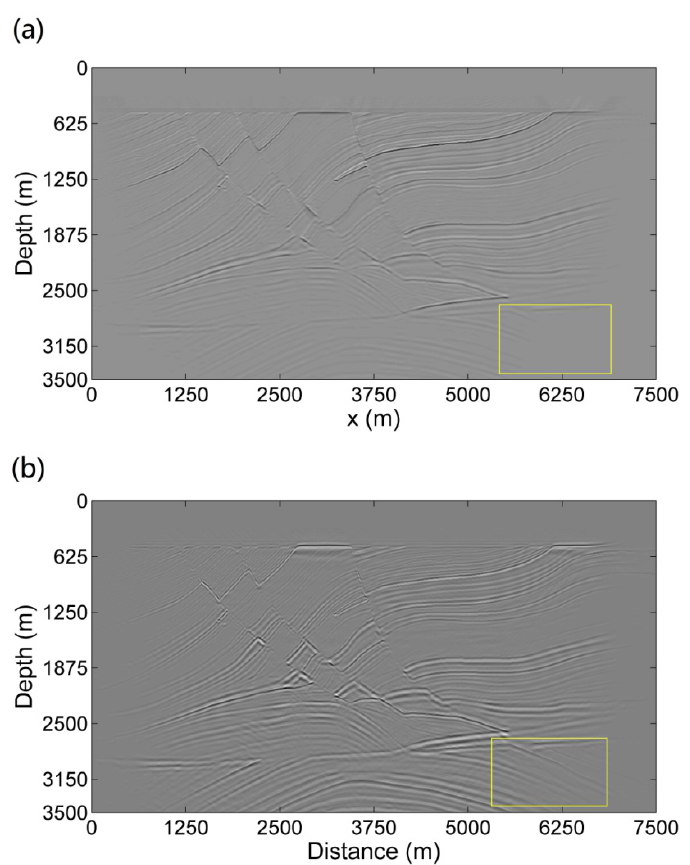
Figure 5. ( a ) The imaging result of reverse time migration (RTM); ( b ) The imaging result of our proposed method.